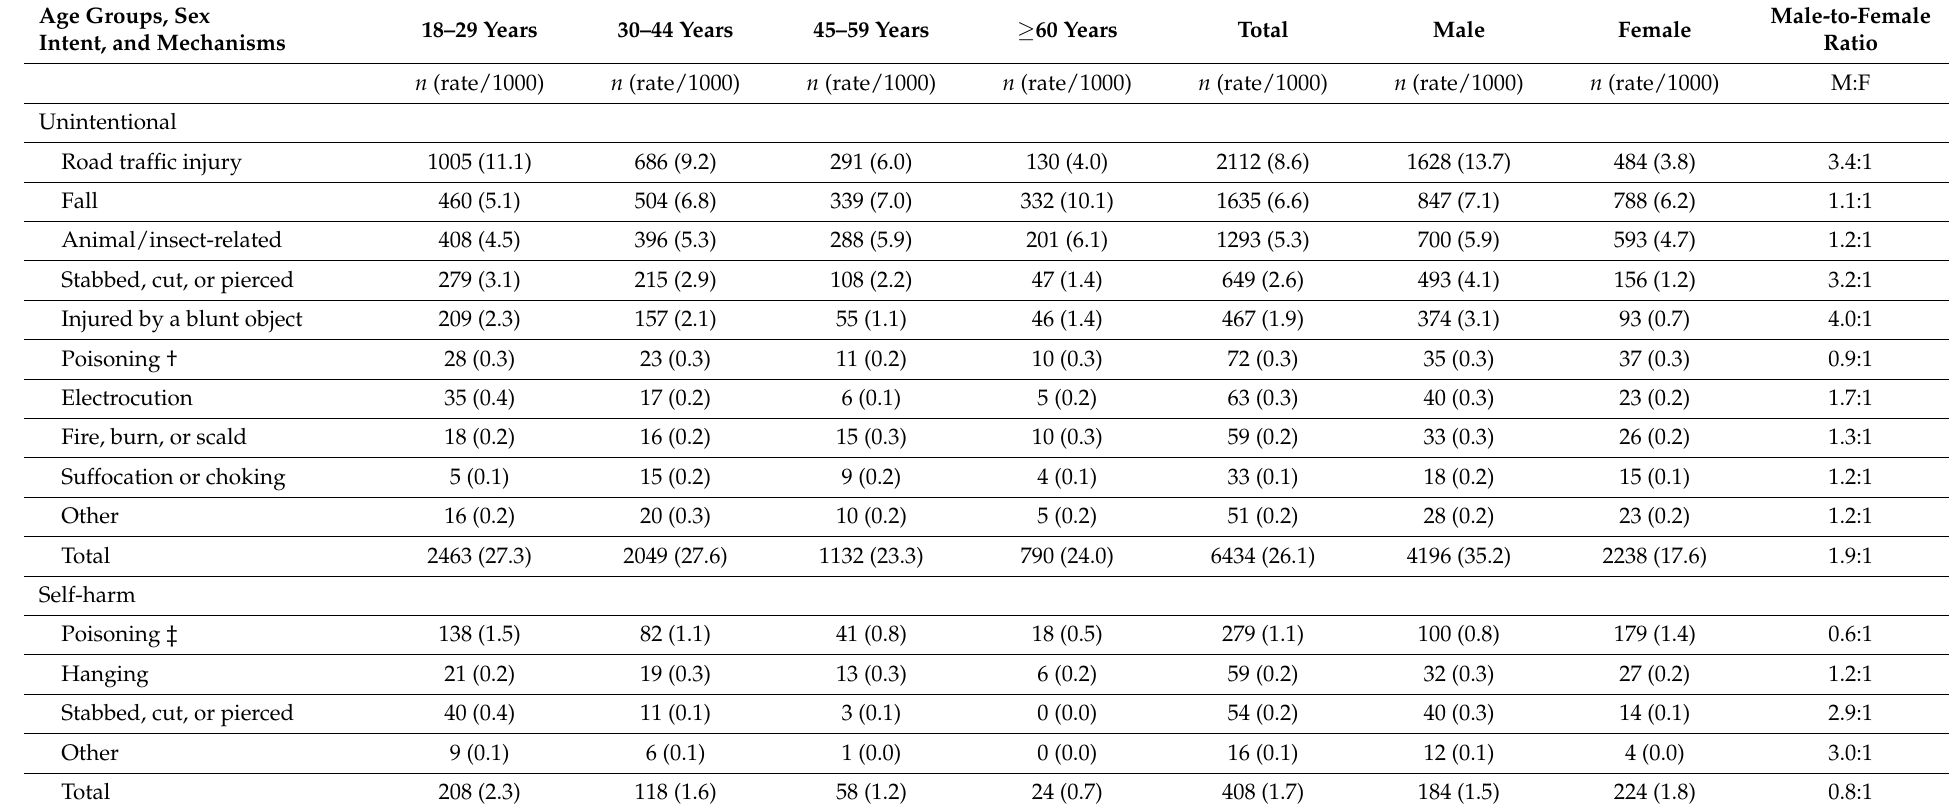
Table 2. Number and rates of EDs attendance with injury-by-injury mechanisms, age, and